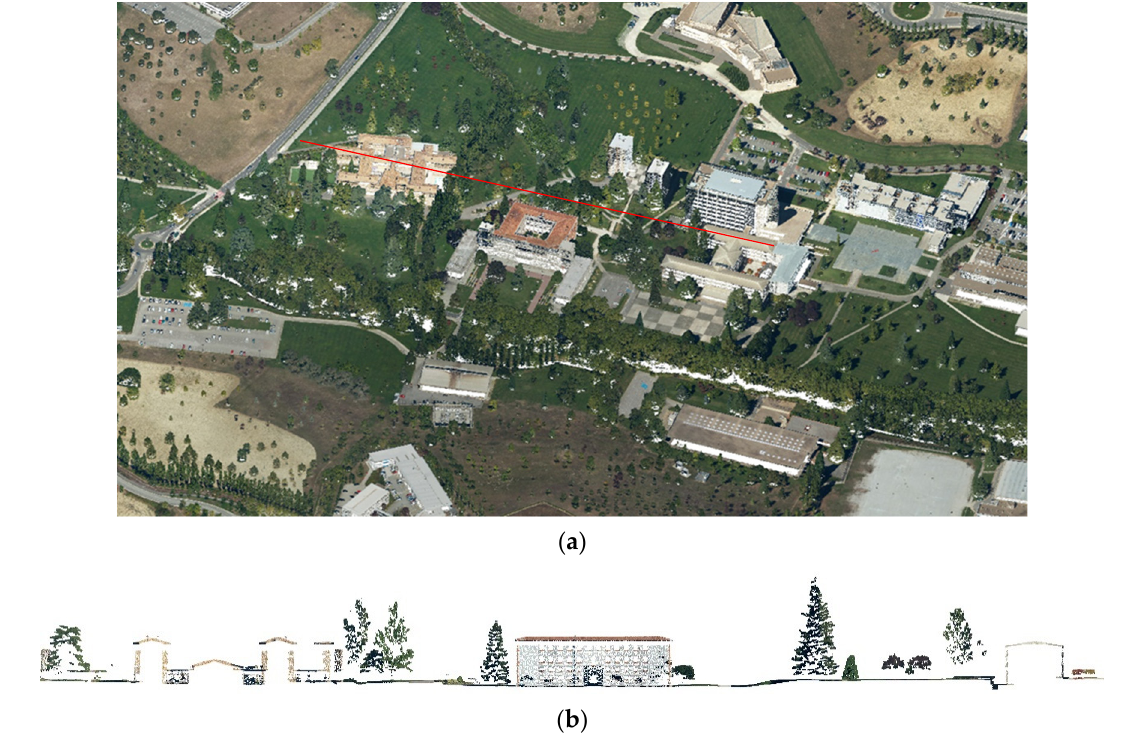
Figure 2. LiDAR 2017 point cloud, density: 14 points/m 2 . UNAV campus: ( a ) 3D color cloud; ( b ) vertical section of the cloud through the north façade of the central campus building.